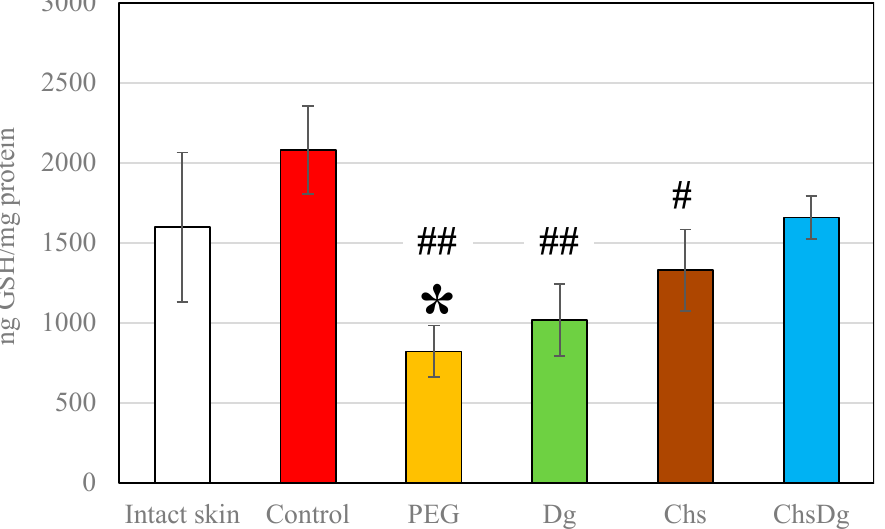
Figure 7. Concentration of total glutathione in intact skin and wound tissues treated with the investigated substances; #— p < 0.05, ##— p < 0.01 vs. control; *— p < 0.05 vs. intact skin .